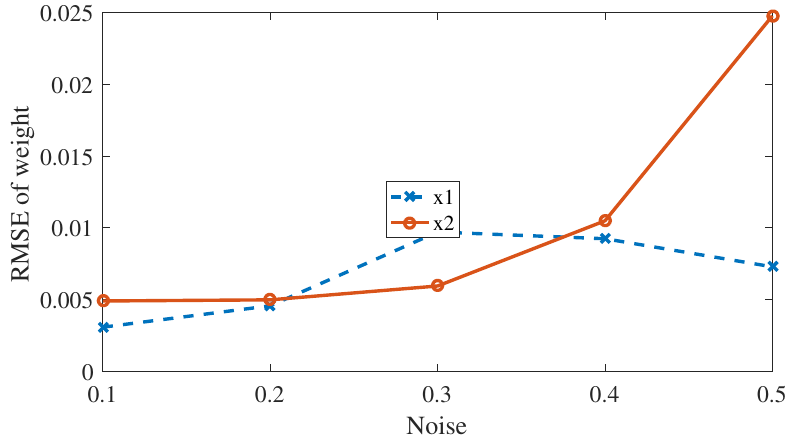
Figure 1. RMSE of state x 1 and x 2